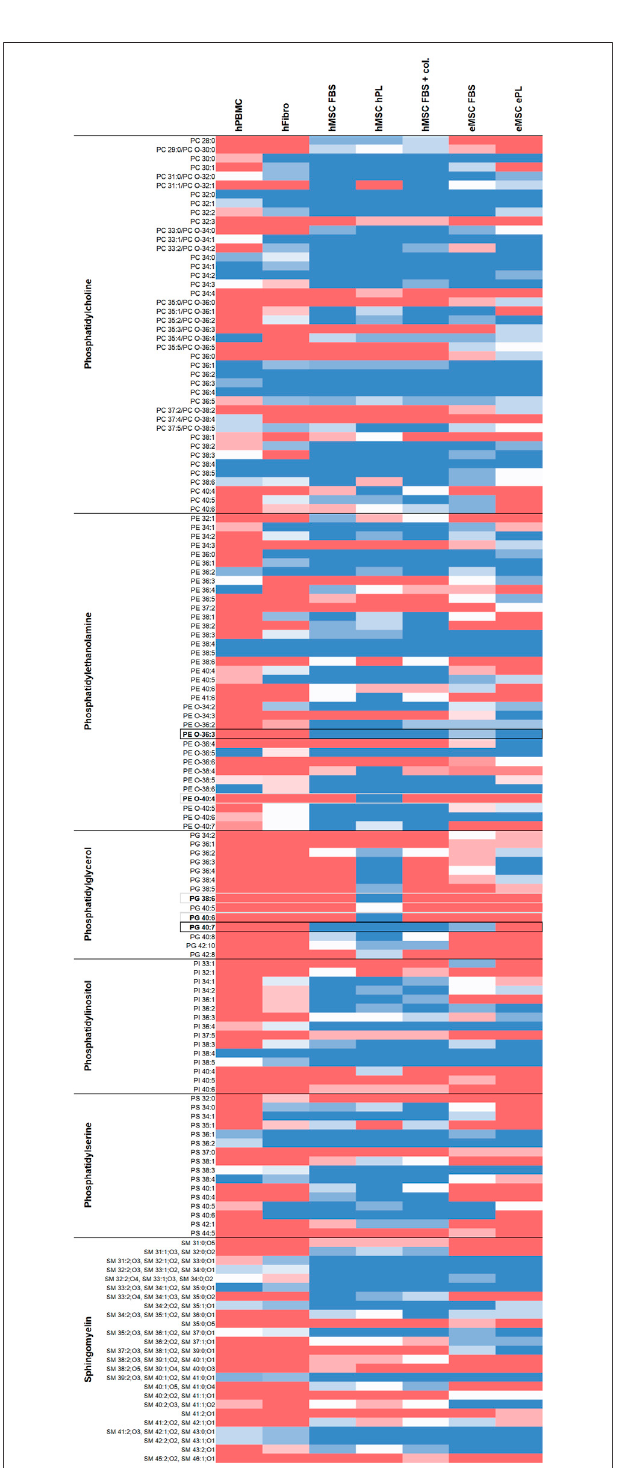
FIGURE 1 | due to corresponding ether lipids also present, are labeled with asterisks (*). Phospholipid species potentially suitable for inclusive